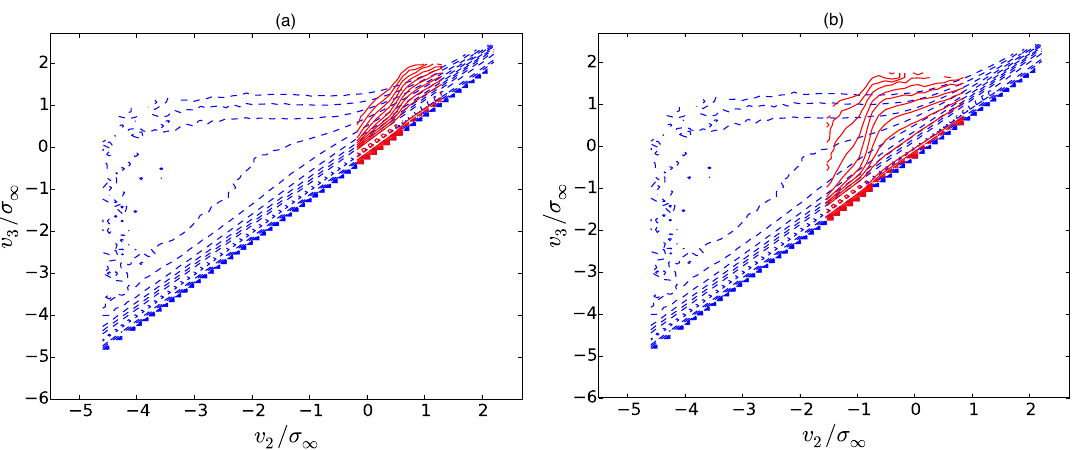
Figure 8. ( a ) examination of the Markov property (28) from DNS of Burgers turbulence for ∆ r = 0.2 λ and v 1 = 0. The Markov property is violated as the transition PDF (red) overestimates the correlations that is exhibited by the conditional PDF (blue); ( b ) same as in (a), but for v 1 = − σ ∞ . The violation of the Markov property becomes even more